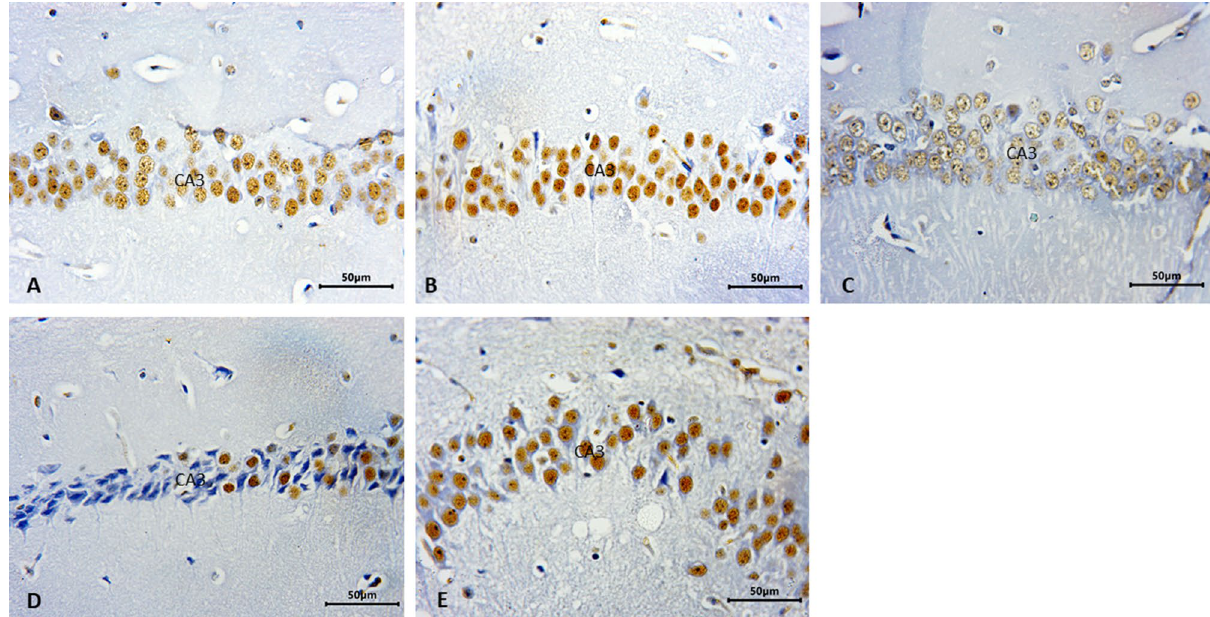
Figure 6. Representative micrograph INI-1 expression in CA3 showing strong expression in the control olive oil group ( A ), blank nanoemulsion group ( B ), gum Arabic loaded nanoemulsion group ( C ) and bromobenzene + gum Arabic loaded nanoemulsion group ( D ). Weak reaction in bromobenzene group ( E ).